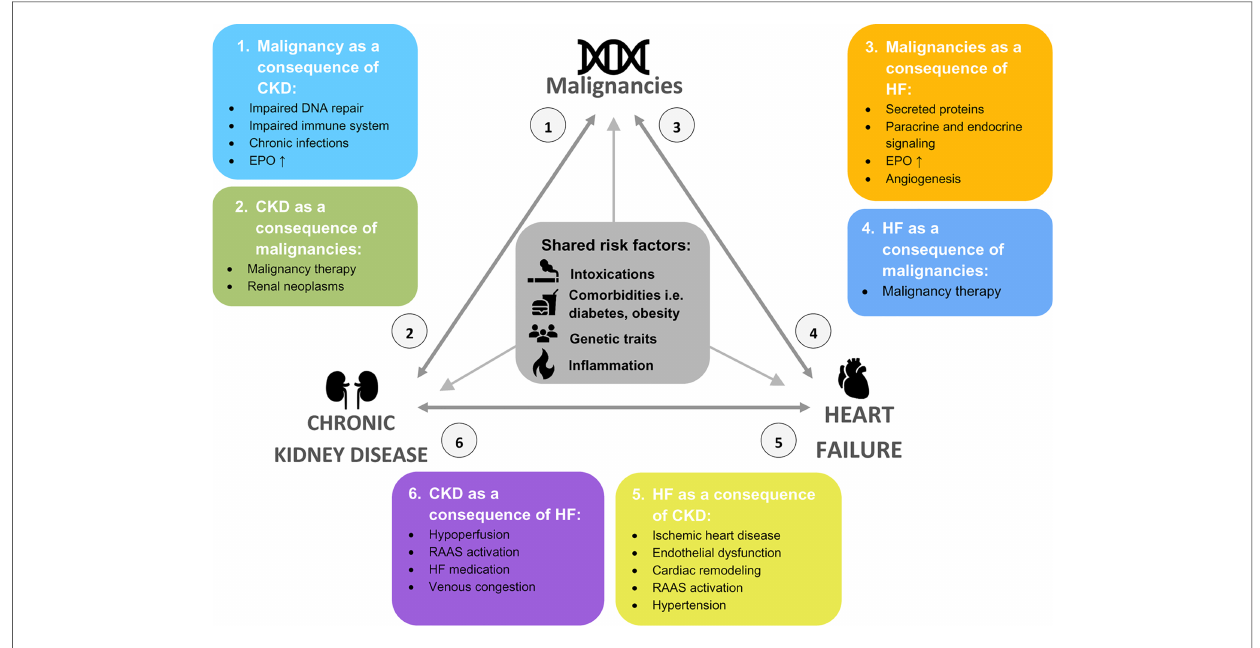
Graphical Abstract In fl uence of Chronic Kidney Disease and Other Risk Factors Pre-Heart Transplantation on Malignancy Incidence Post-Heart